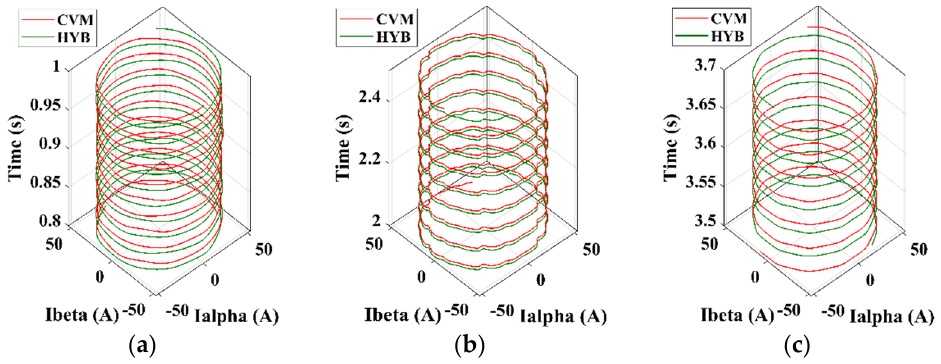
Figure 16. Alpha-beta stator current response: ( a ) at 1470 rpm, ( b ) at 500 rpm and ( c ) at 1000